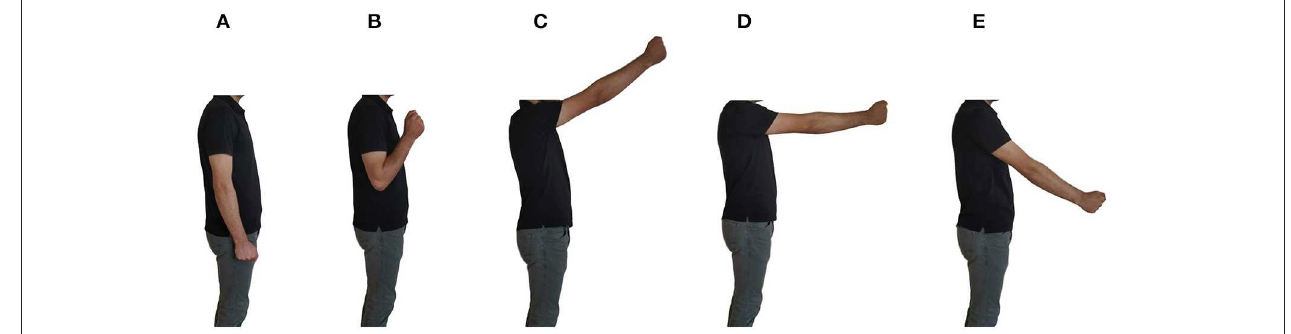
FIGURE 4 | The dynamic protocol used for dataset2 and dataset3. Participant moved his arm through positions (A–E) in a circular